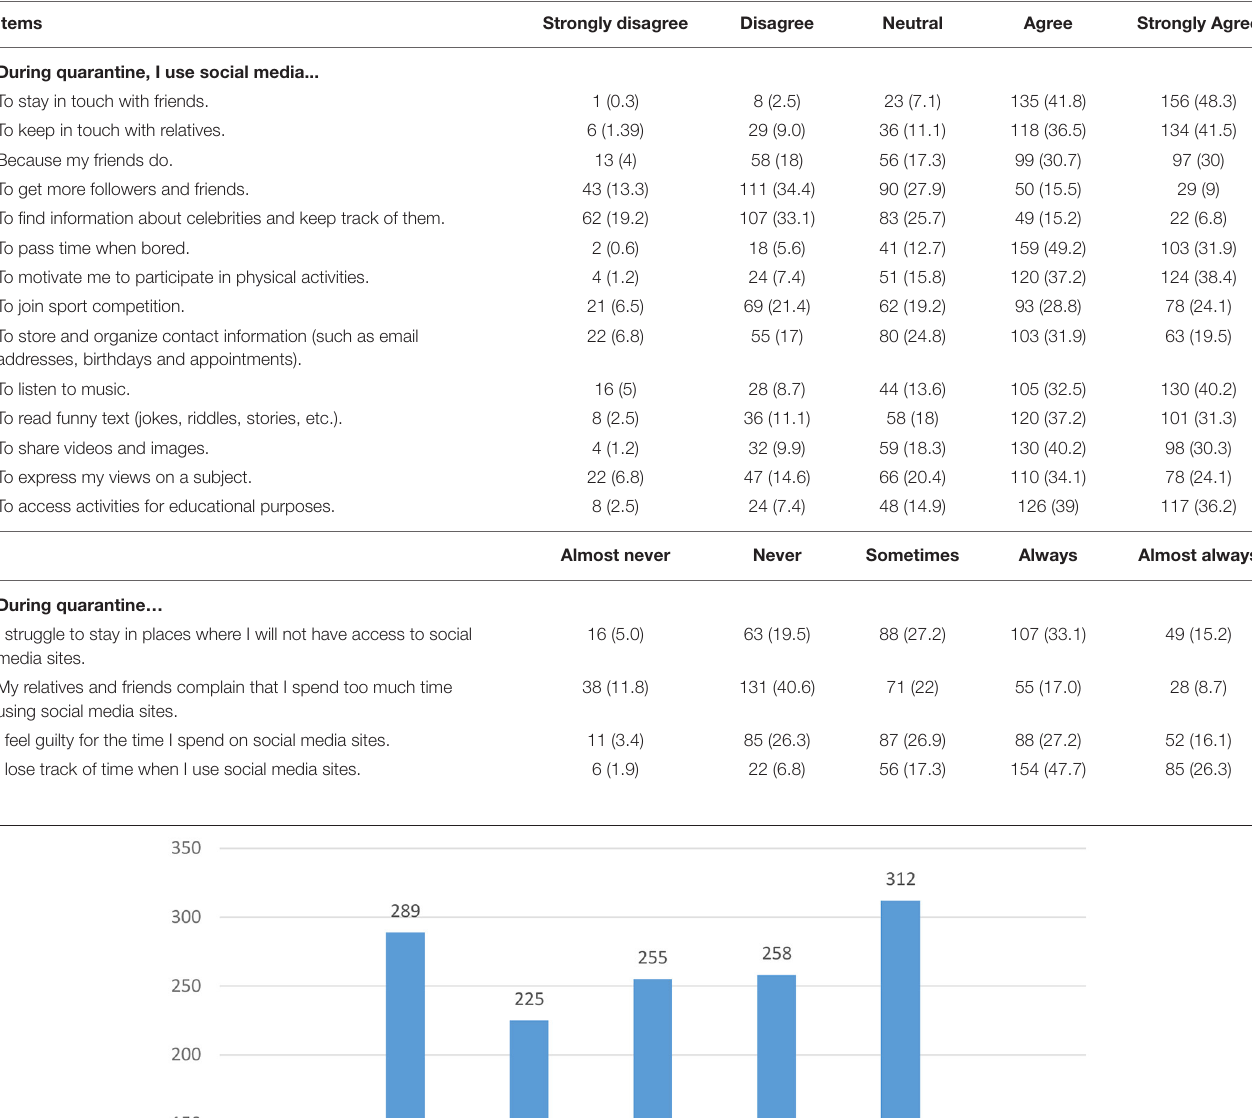
TABLE 2 | The frequencies of participants in terms of their attitudes toward social media. Items Strongly disagree Disagree Neutral Agree Strongly Agree During quarantine, I use social media...